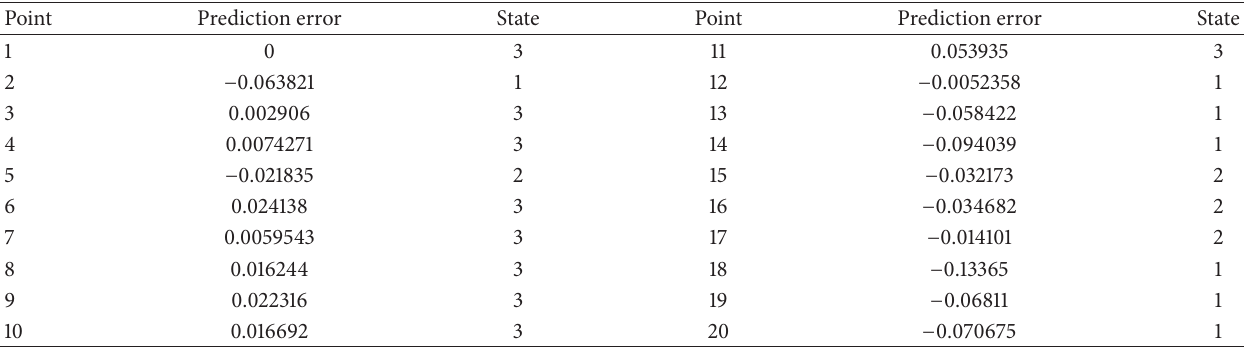
Table 6: The result of the state division and the prediction results.